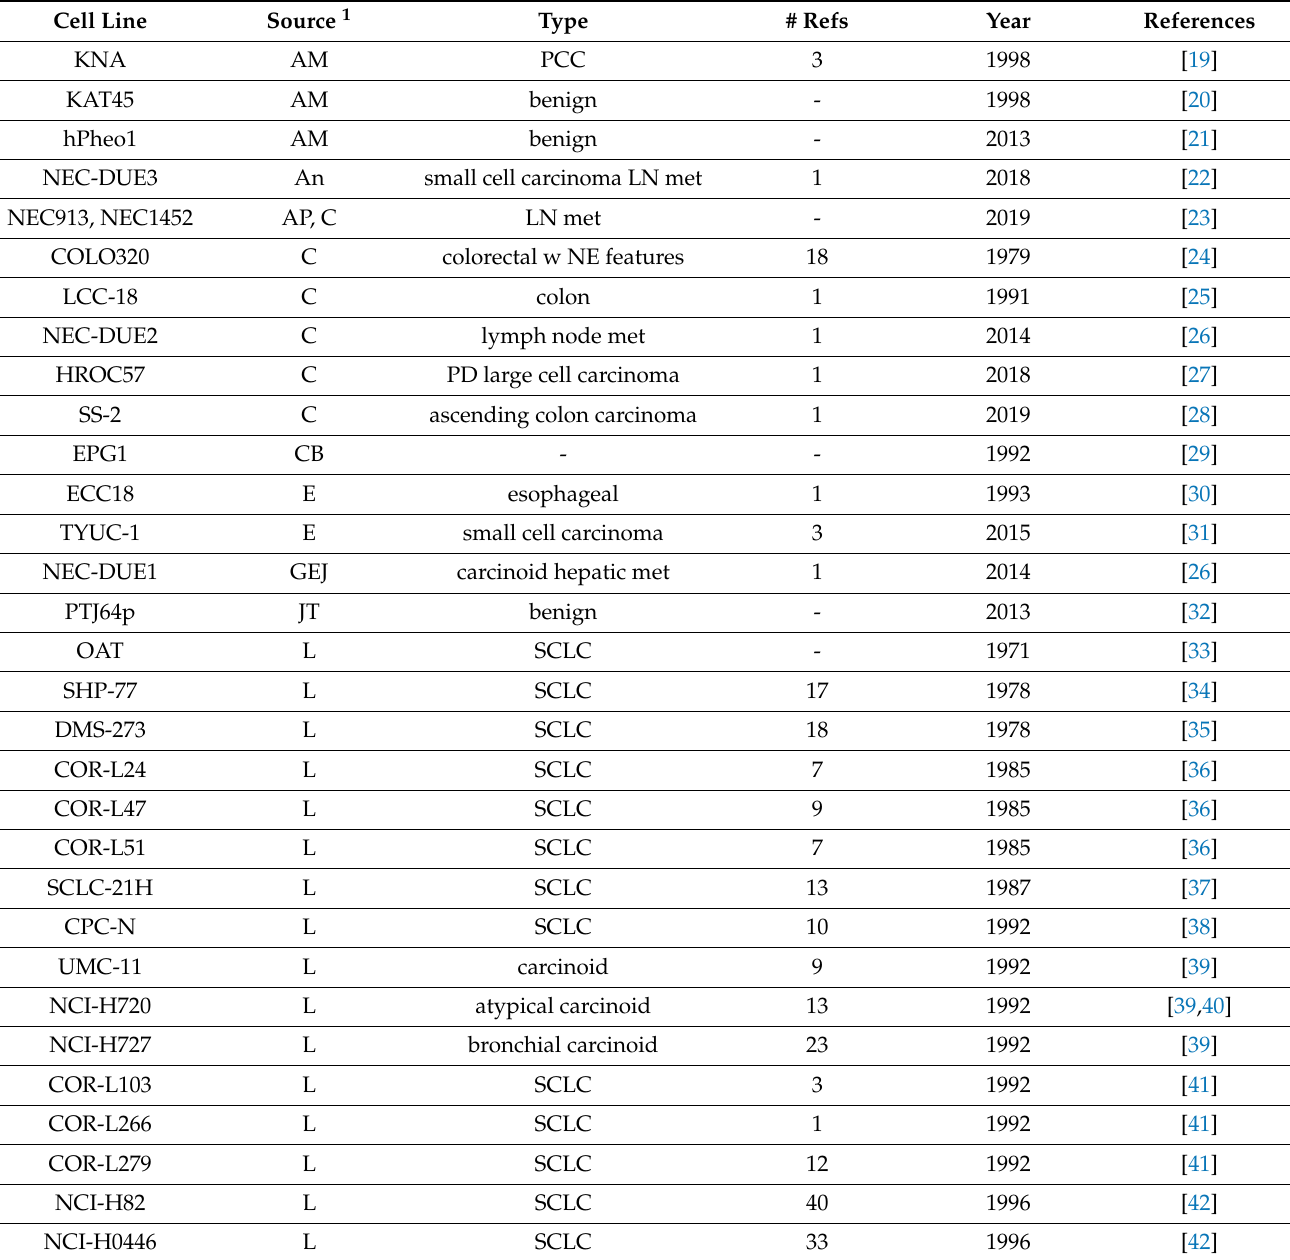
Table 1. Human neuroendocrine neoplasm-derived cell